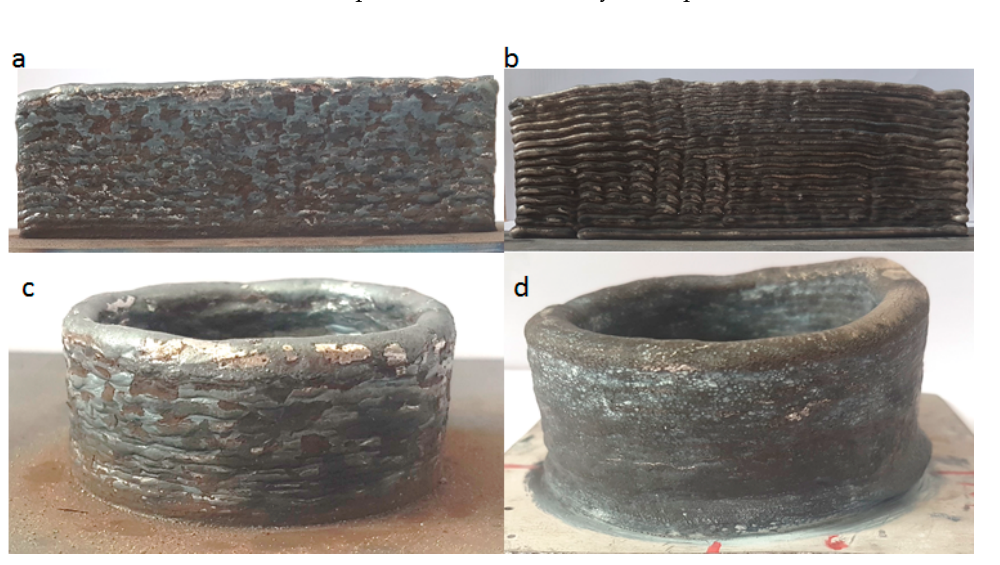
Figure 7. Comparison of measured (solid line) and simulated (dotted line) temperatures of the discontinuous welding process for G4Si1 with v wire = 5.0 m/min and v welding = 40 cm/min.